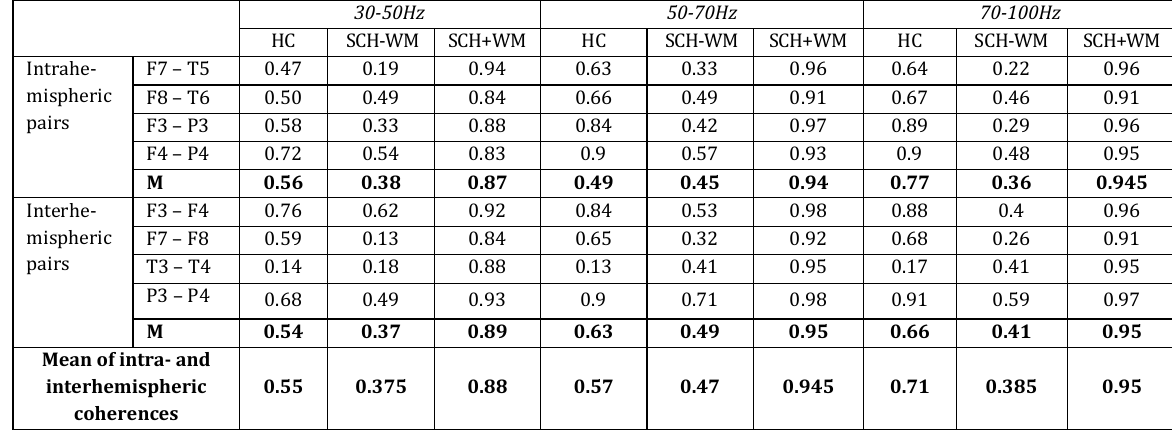
Tab.1 The table contains average coherence values for three frequency bands 30-50Hz, 50-70Hz and 70-100Hz, for each subject individual. Each electrode pairs were split for two groups intrahemispheric and interhemispheric. Third row placed on the bottom of the table shows mean of intra and interhemispheric average coherences values